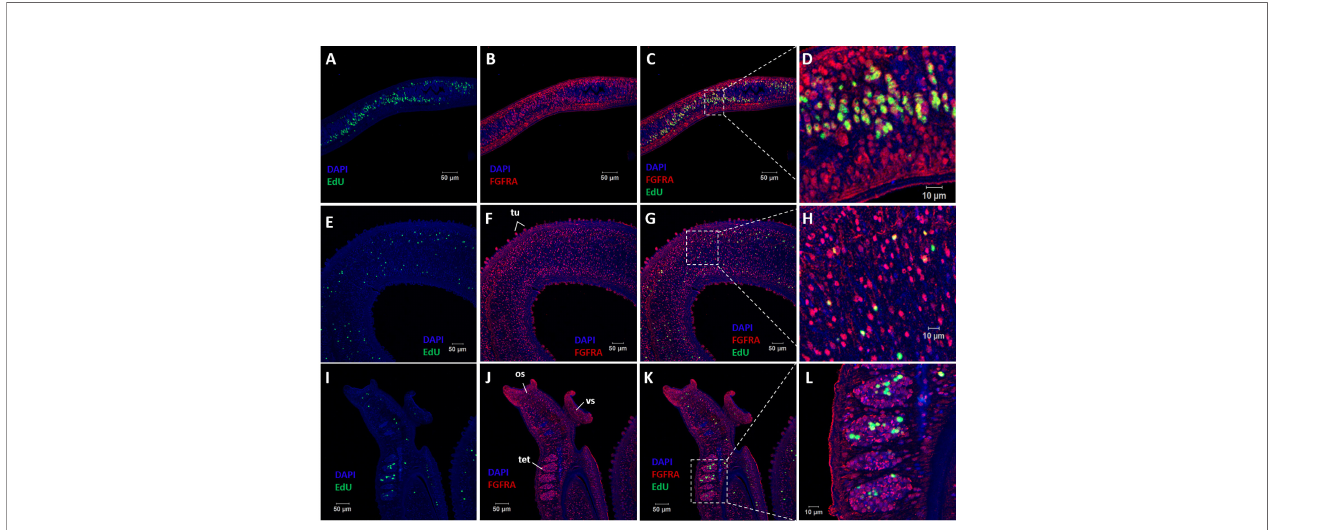
FIGURE 5 | Co-localization of SmFGFRA and EdU + cells in S. mansoni adult worms. Sequential staining of (A) EdU (green) and (B) anti-rSmFGFRA-L antibody (red) to sections of adult female worms. (C) Merging of (A, B) . (D) Magni fi ed squared-areas in (C) . Sections of adult male worms were stained with (E, I) EdU and probed with (F, J) anti-rSmFGFRA-L antibody. (G) Merging of (E, F) . (H) Magni fi ed squared-areas in (G) . (K) Merging of (I, J) . (L) Magni fi ed squared-areas in (K) . All samples were DAPI-stained (blue). os, oral sucker; vs, ventral sucker; tet, testes; tu,